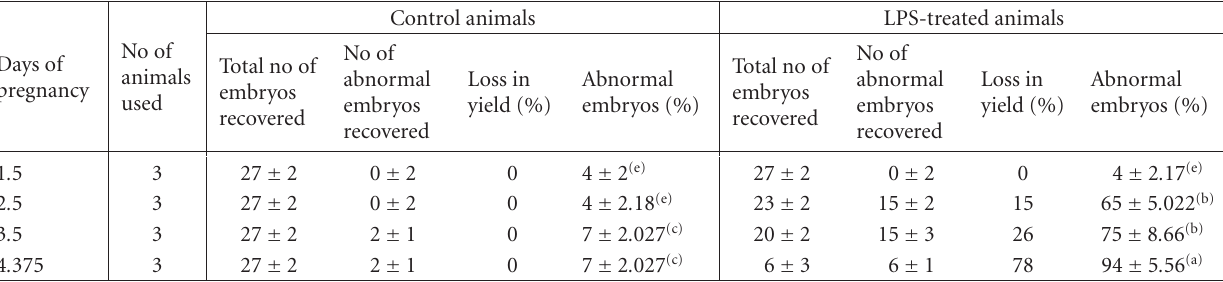
Table 1: E ff ect of the “minimum e ff ective dose” of LPS on development of preimplantation stage embryos collected from nonsuperovulated pregnant animals. Data is expressed as mean ± 1 SEM, with all values given in (%) of abnormal embryos . Means bearing similar superscripted alphabets do not di ff er from each other at P ≤ . 05 (based on Duncan’s multiple range test) . ANOVA : treatment (T), F-value = 304 .